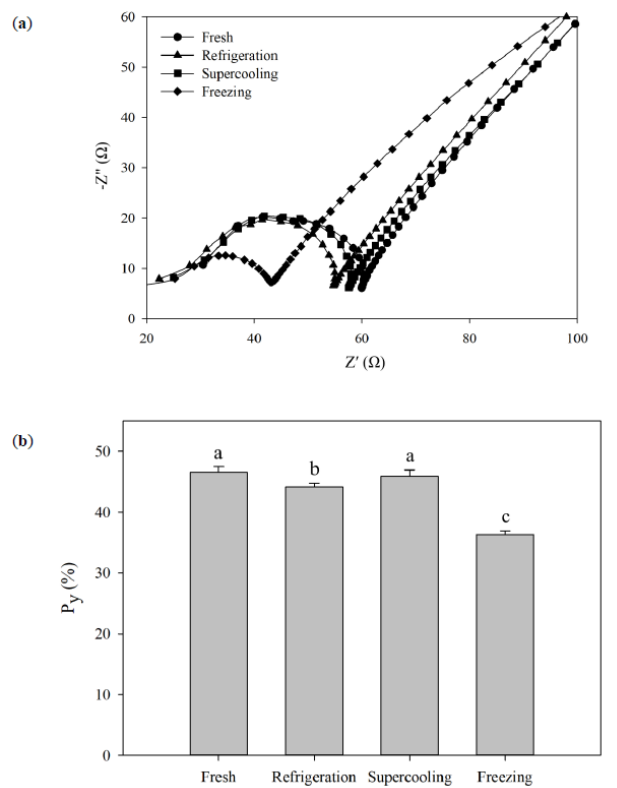
Figure 3. Nyquist plots ( a ) and the calculated 𝑃 𝑦 values ( b ) of tuna (80 g) preserved at different storage conditions after 8 days. Error bars represent standard deviations, and different letters indicate significant differences ( p < 0.05) between treatments.